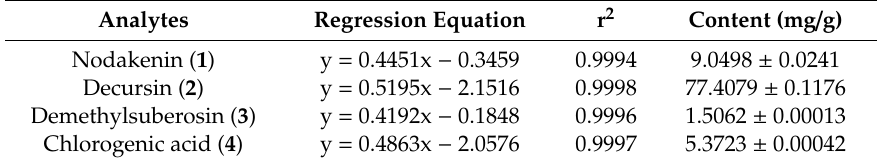
Figure 5. Structures of the four major compounds ( A ), HPLC chromatograms ( B ) of four standard compounds from the EtOH extract of A. gigas identified at UV wavelengths of 330 nm ( C ). nodakenin (1), decursin (2), demethylsuberosin (3), and chlorogenic acid (4) were identified. Table 1. Regression data and contents of four compounds from AGR.